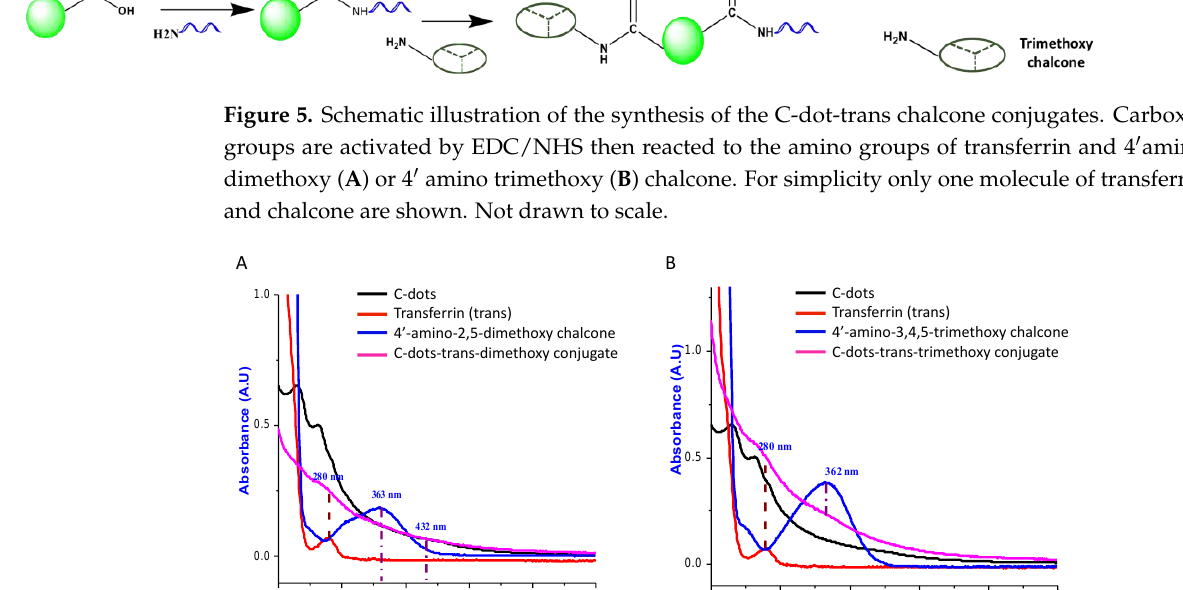
Figure 6. The UV-Vis spectral comparison of C-dots, transferrin, chalcone and C-dot-trans-chalcone. ( A ) Free C-dots transferrin, dimethoxy chalcone 3f (4′amino - 3,5,dimethoxy), and C-dots-trans-dimethoxy conjugate. ( B ) Free C-dots, transferrin, trimethoxy chalcone 3e (4′ -amino-3,4,5-trimethoxy) and C-dots-trans-trimethoxy conjugate. Samples (20 μg/mL) were tested in a 1 cm quartz cell.